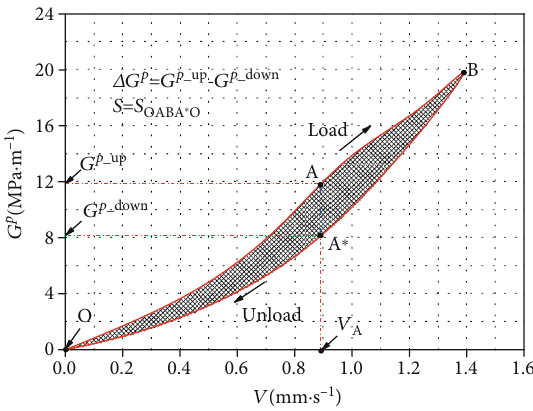
Figure 10: Water-sediment mixture seepage hysteresis loop